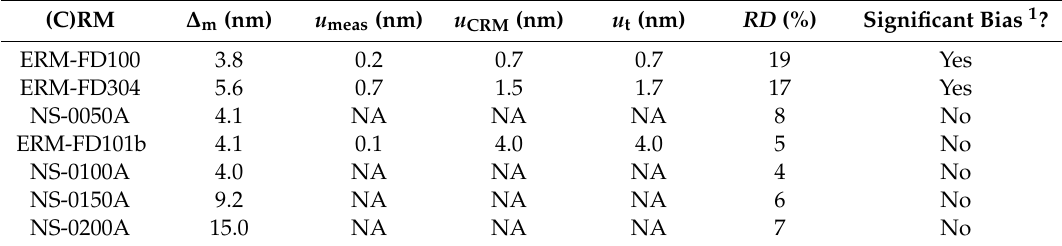
Table 5. Results of the trueness